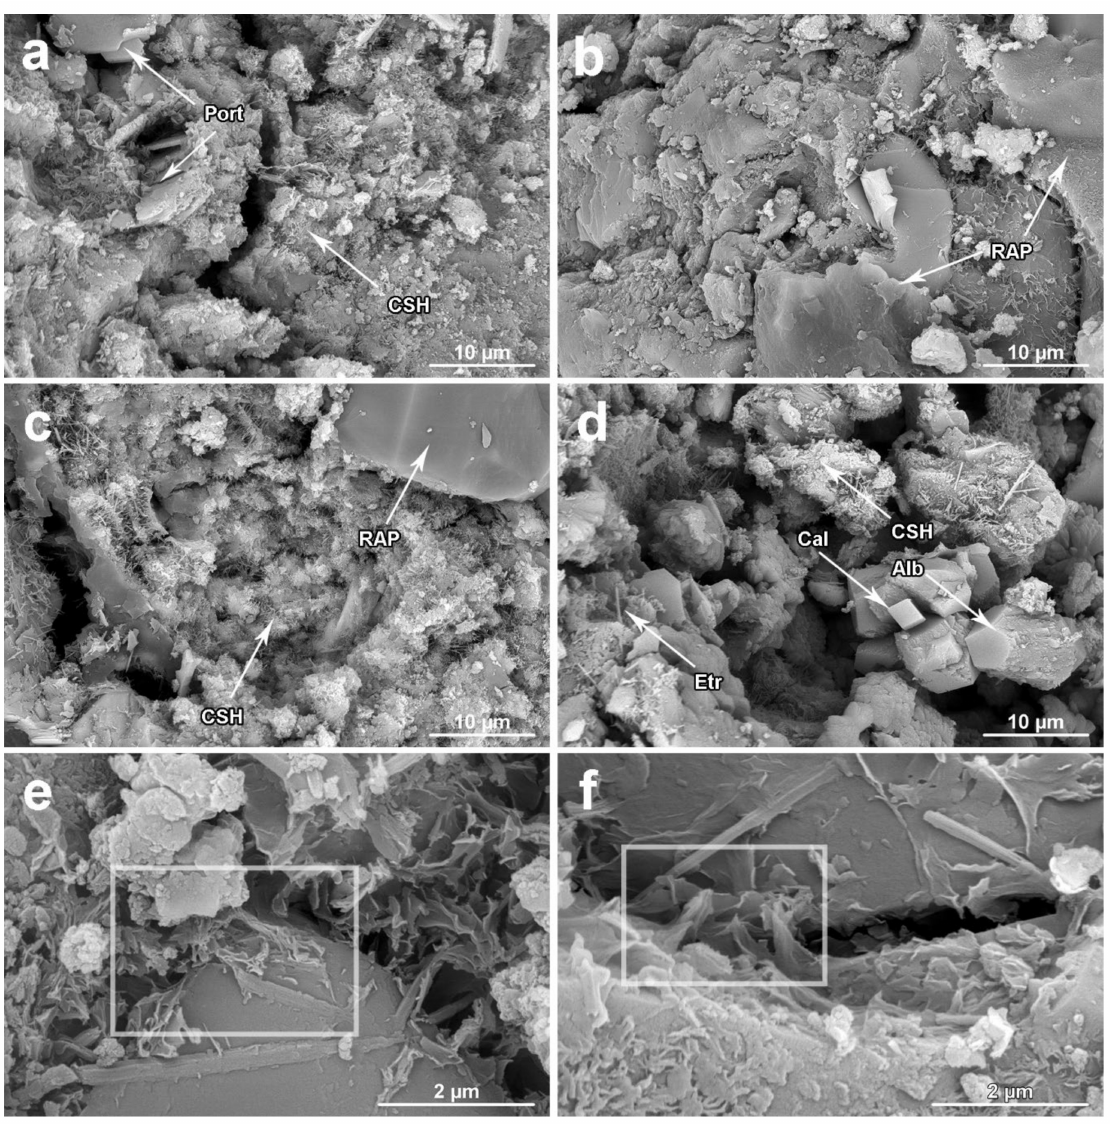
Figure 12. SEM micrographs of RC ( a ), RA-C 10 ( b ), RA-C 50 ( c ), RA-C 100 ( d ) specimens and an examples of ITZ zones (highlighted within inserted rectangles between RAP and cement matrix ( e ) and in the system of RAP-cement-RAP) ( f ). Some phases were identified according to their typical